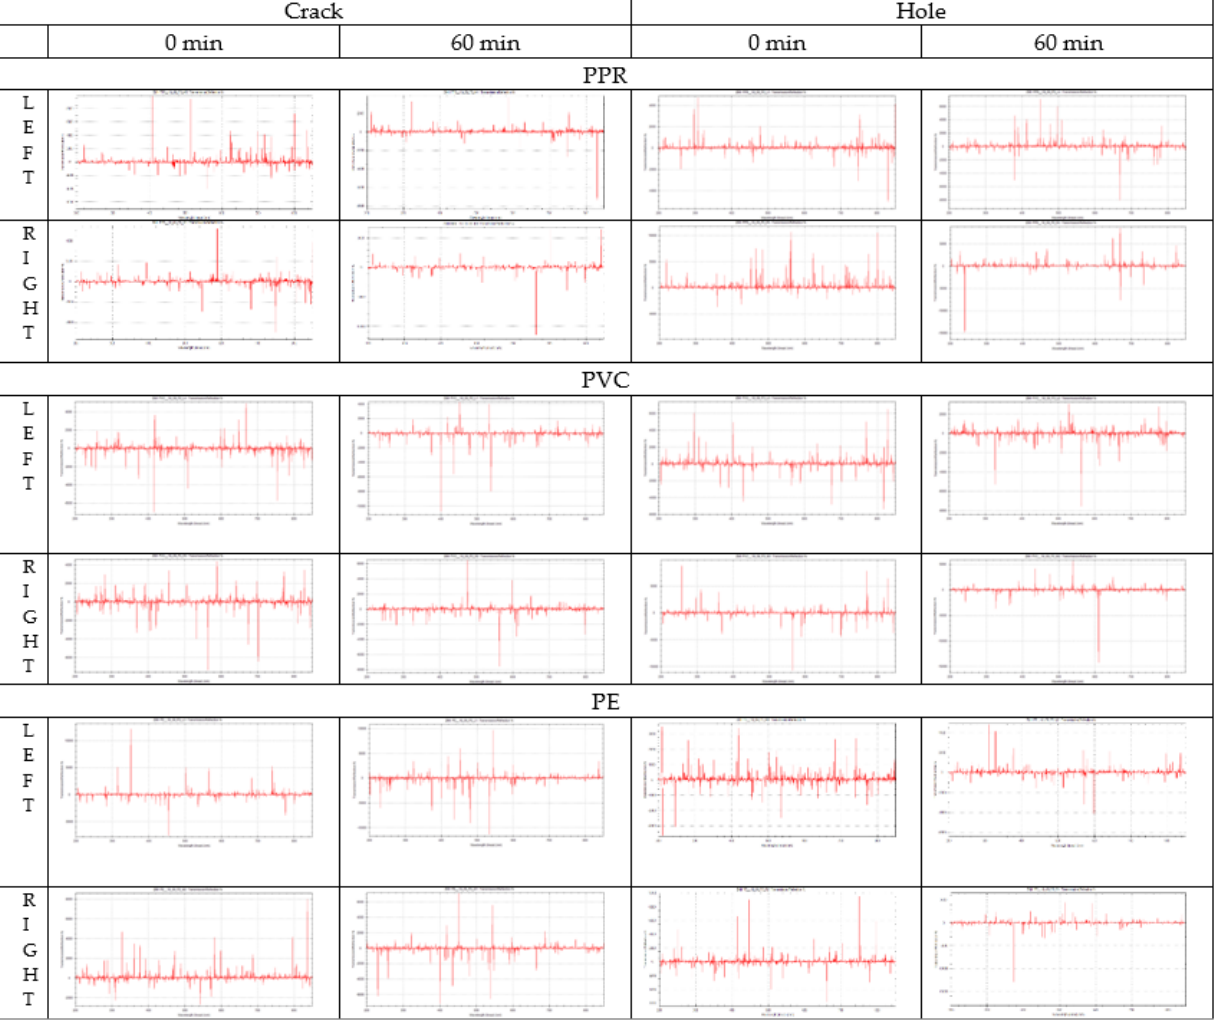
Figure 17. Spectrometer reflectance obtained against different wavelengths on PPR, PVC and PE setup with 2% soil moisture content.